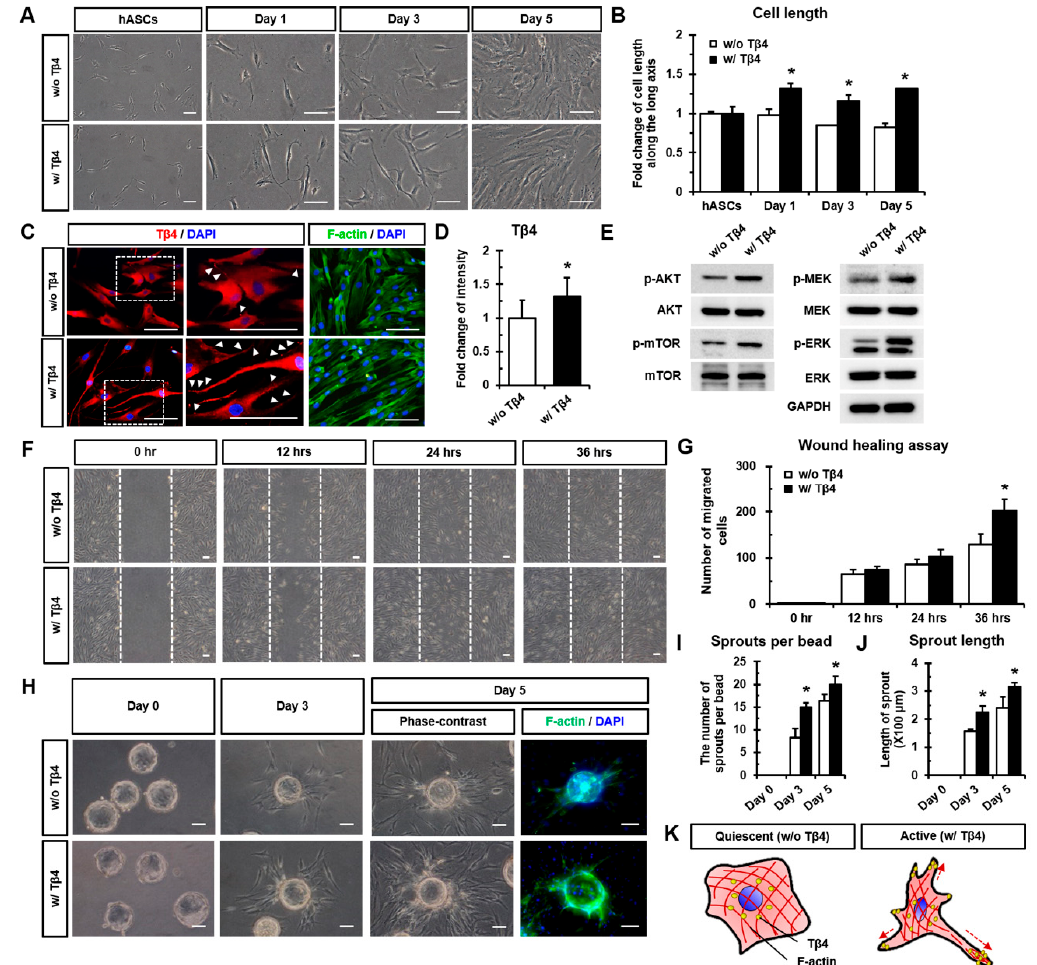
Figure 2. T β 4 induces the active state of hASCs. ( A ) Representative phase-contrast images and ( B